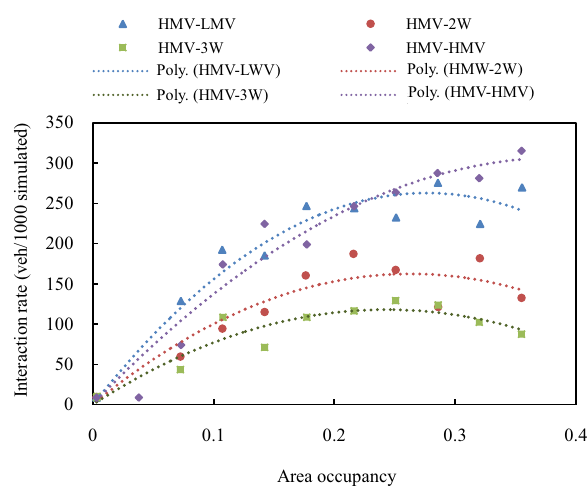
Fig. 16 Simulated interaction rates between HMV and different vehicle types for different values of